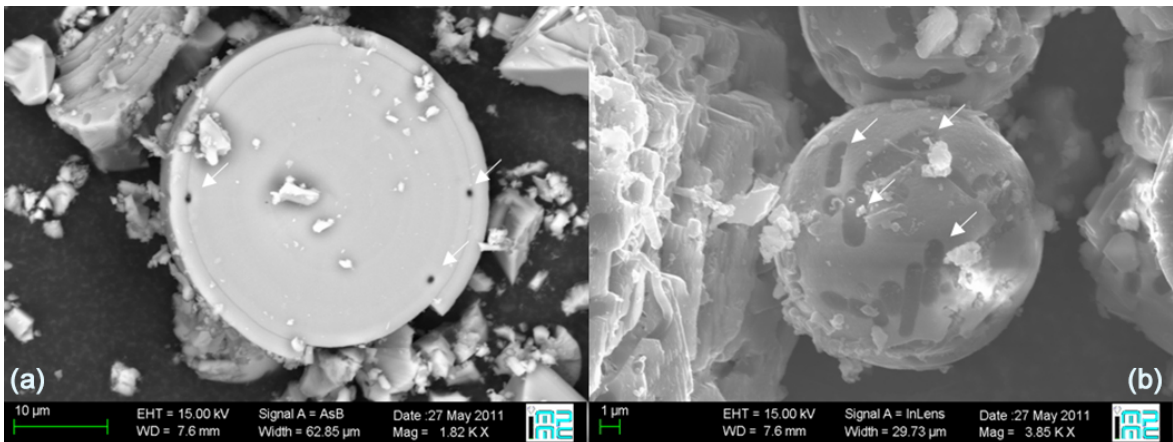
Figure 1. Scanning electron microscopy images of the bio-induced carbonates formed with CA (almost pure calcite and traces of vaterite and aragonite as determined using X-ray diffraction; Thaler et al., 2017). The fingerprints of Sporosarcina pasteurii cells are visible as black holes ( a showing a cross section of carbonate) or as rods and indicated by white arrows.